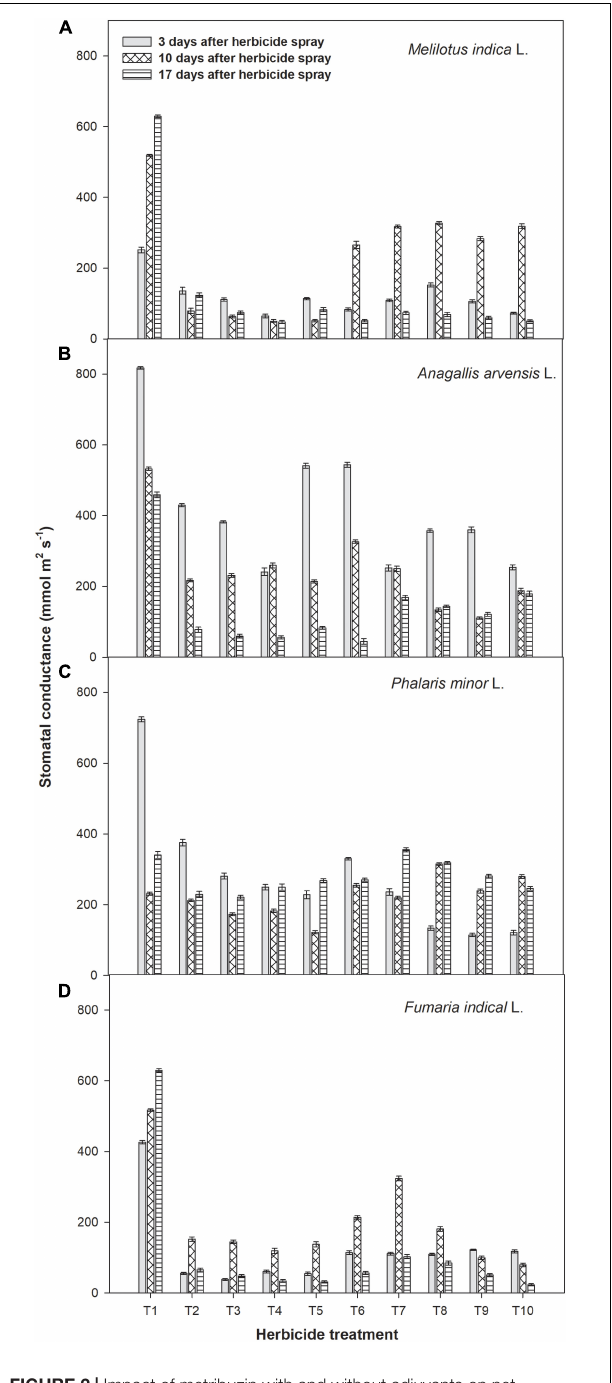
FIGURE 2 | Impact of metribuzin with and without adjuvants on net photosynthetic rate of Melilotus indica L. (A) , Anagallis arvensis L. (B) , Phalaris minor L. (C) , and Fumaria indica L. (D) at 3, 10, and 17 days after herbicide spray (average of 2 years’ data). T 1 , weedy check; T 2 , metribuzin at 175 g